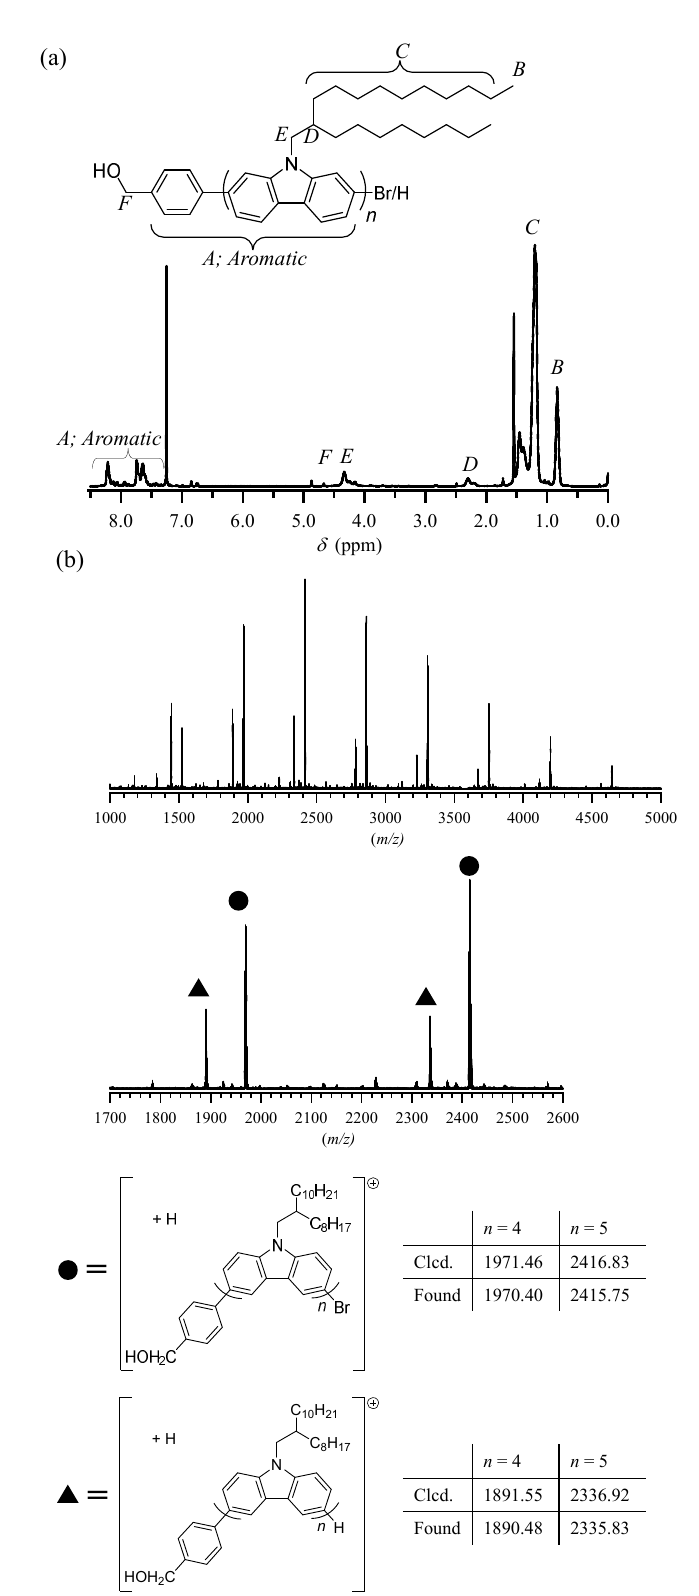
Figure 3. 1 H NMR and MALDI-TOF mass spectral analysis of HOCH 2 −3,6-PCz obtained from run 3 (Table 1). ( a ) 1 H NMR in CDCl 3 (400 MHz). ( b ) MALDI-TOF mass spectrum with peak assign- ments.